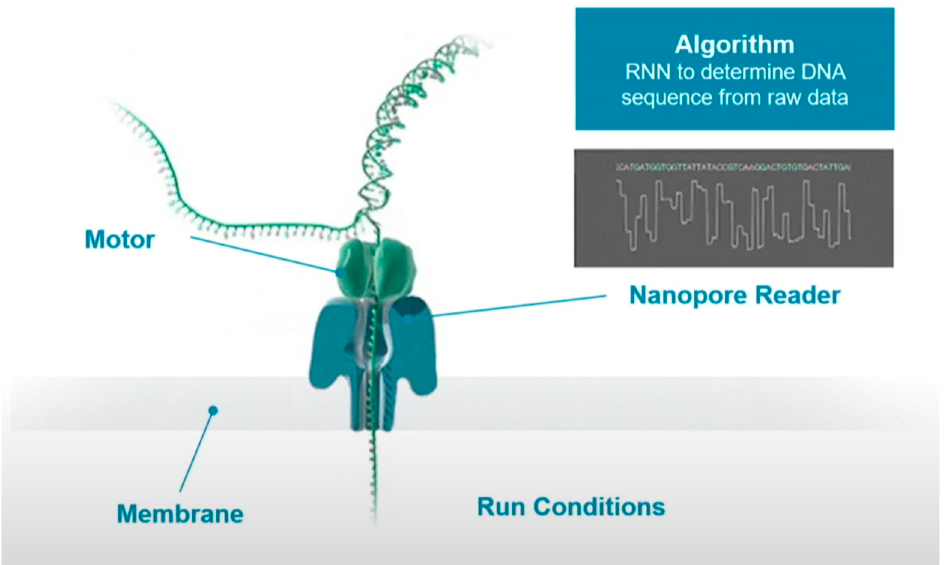
Figure 2. The process of nanopore sequencing [38] .